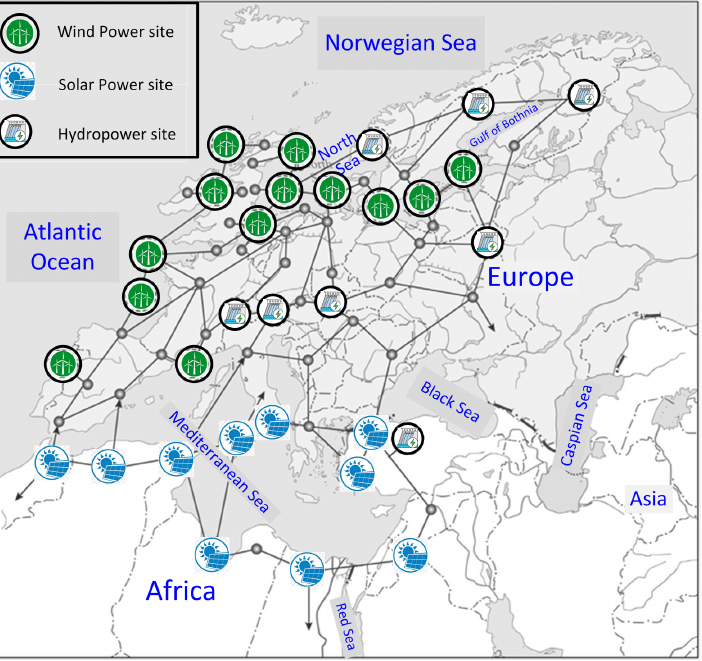
Figure 7. A conceptual plan of a European supergrid linking renewable energy projects [21]. Table 1. Existing interstate electric ties in Northeast Asia